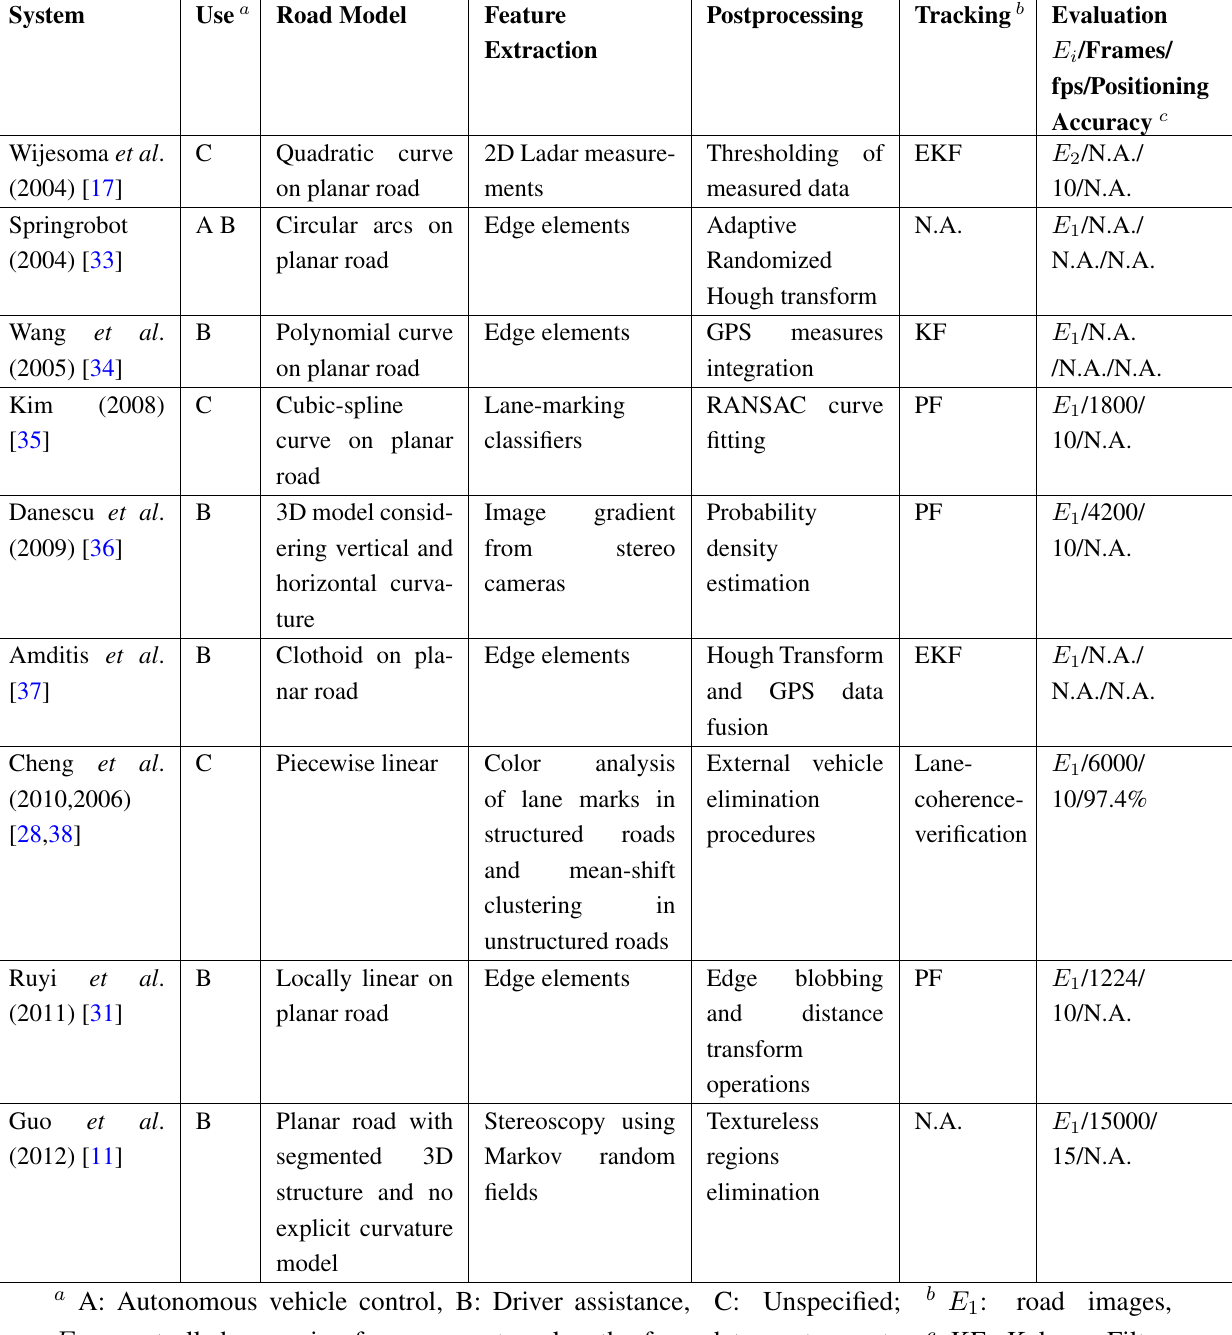
Table 1. Comparison of a selection of lane detection and tracking approaches published in 2004–2012 (see the recent surveys [10,12] for in-depth discussions about foundational and influential developments in lane